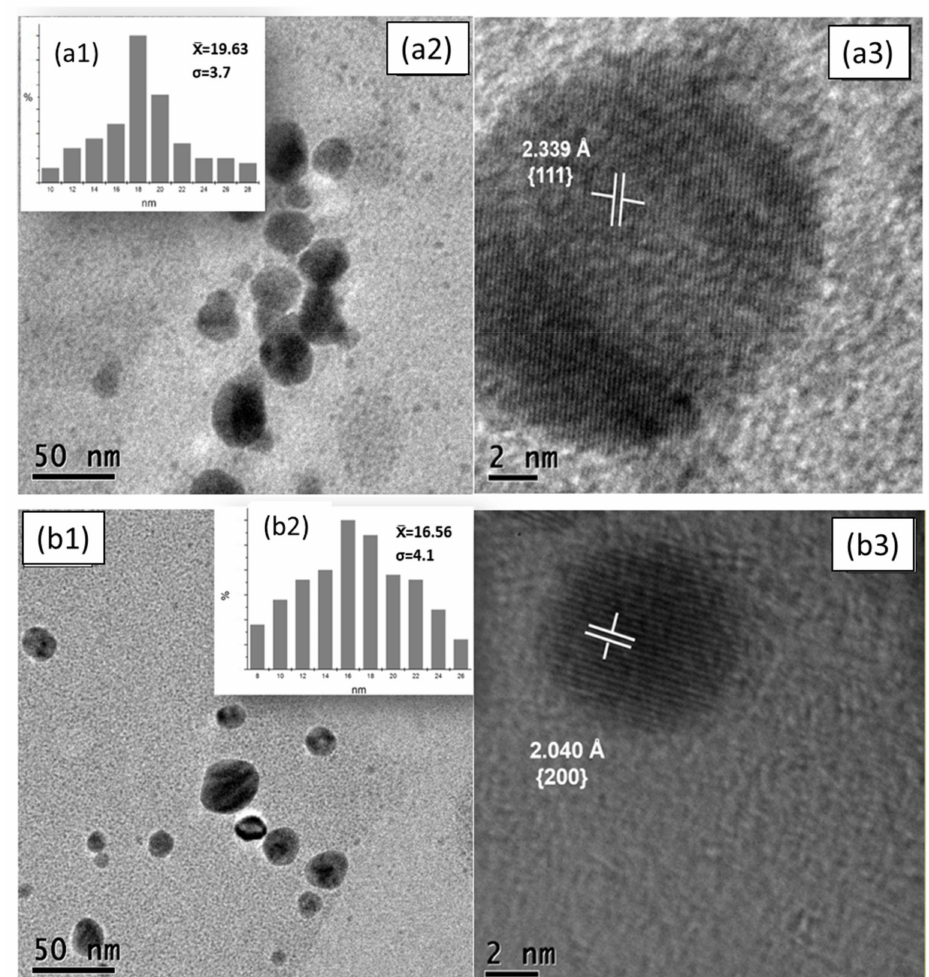
Figure 4. Micrograph obtained by TEM of AgNPs, as well as size distribution graph and HRTEM. The micrographs show the nanoparticles generated from the extracts of leaves and fruit peels of Annona muricata . The LE-AgNPs generated show an average diameter size of 19.63 ± 3.7 nm ( a1 ) and a quasi-spherical shape ( a2 ). The inter-planar spaces with a distance of 2339 Å were determined for the AgNPs-PE which corresponds to the family of planes (111) ( a3 ). The LE-AgNPs generated show a quasi-spherical shape, individualized AgNPs can be seen without agglomerations ( b1 ). The average diameter size of 16.56 ± 4.1 nm for the AgNPs-PE ( b2 ). The inter-planar distances of the AgNPs-LE were measured, obtaining a distance of 2040 Å, which corresponds to the family of planes (200) ( b3